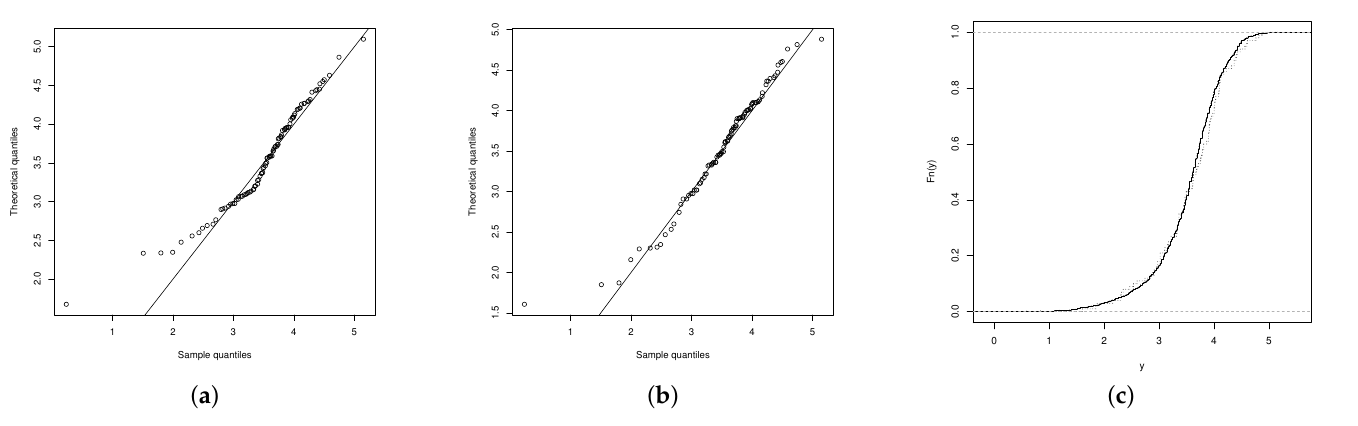
Figure 3. QQ-plots fitted using ( a ) the N model, ( b ) the BESN model, ( c ) the cdf of the BESN model (dotted line) and empirical cdf (solid line).